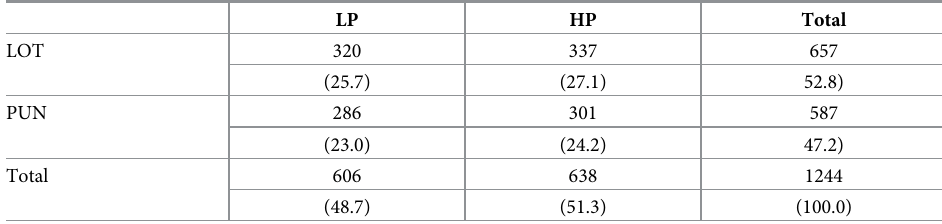
Table 6. Breakdown of respondents by vignette treatments.